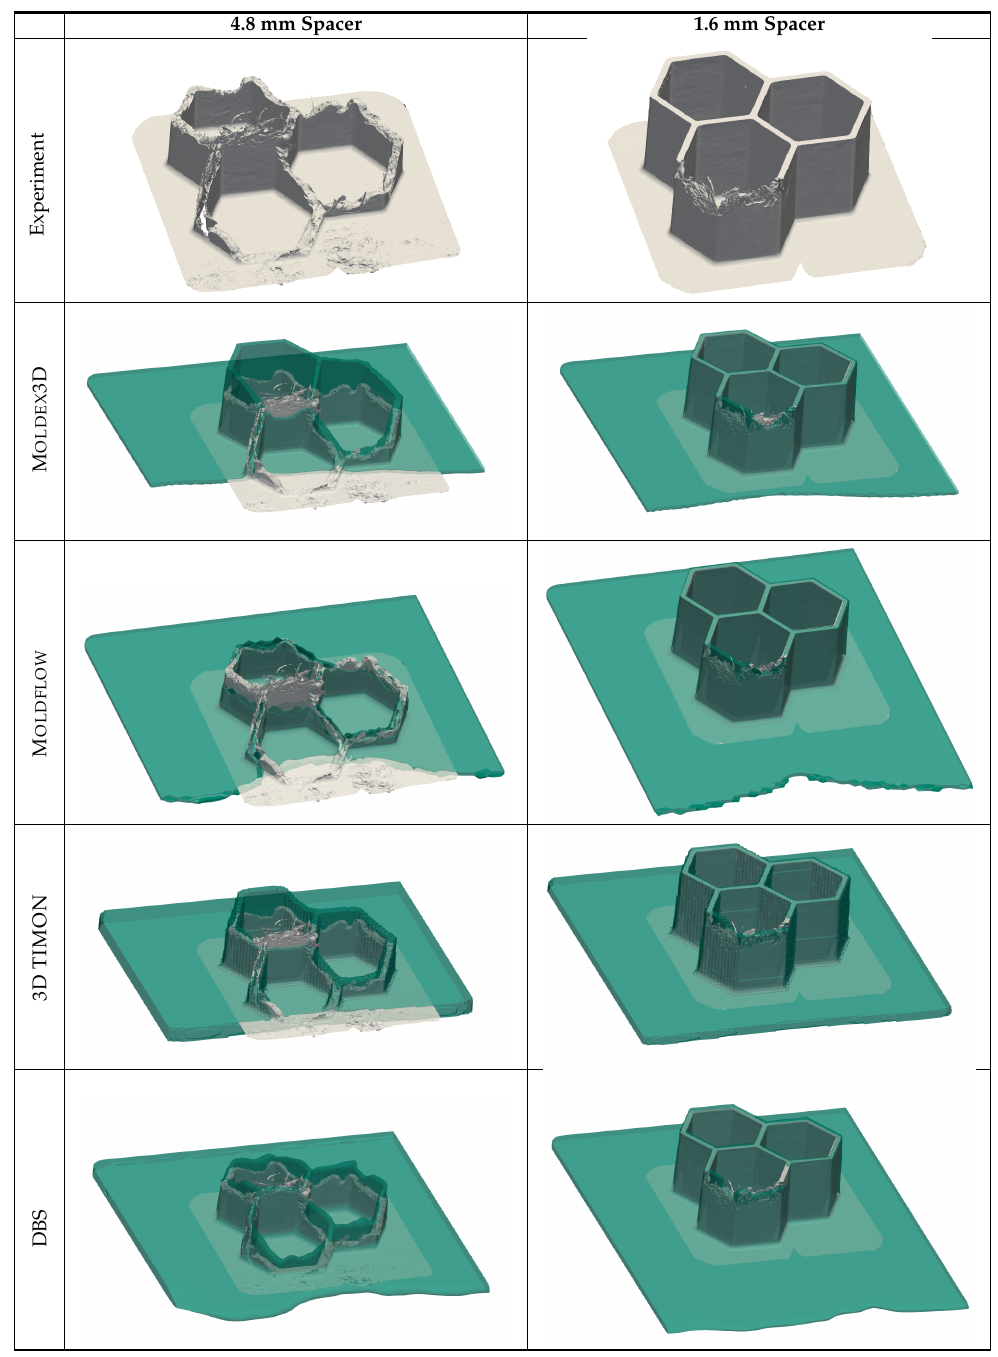
Table 1. Comparison of scans of short shots (gray surfaces) to simulated flow front progression of the matrix phase (green) for Configuration A according to M OLDEX 3D, M OLDFLOW , 3D TIMON and the Direct Bundle